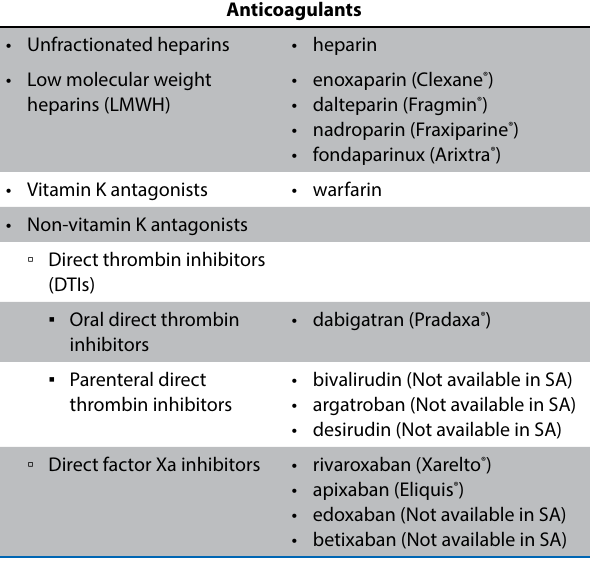
Table 2. Summary of available anticoagulant drugs